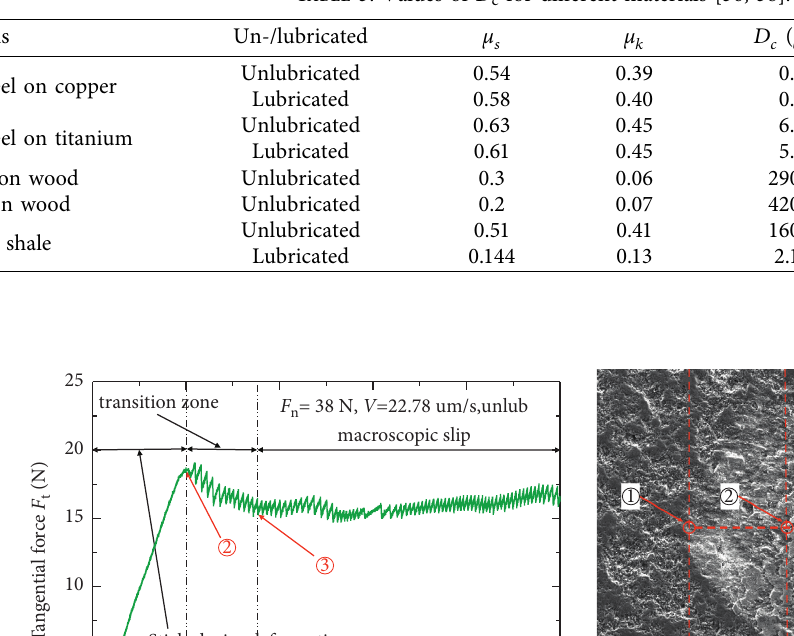
( V � 22 . 78 μ m/ s ) . (a) Unlubricated. (b) Lubricated. c